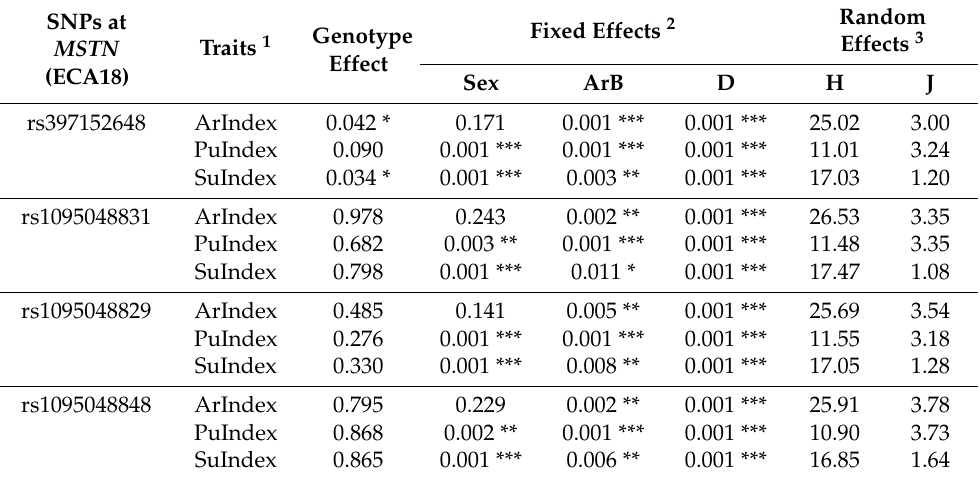
Table 3. Raw p -values and significance for sporting performance traits in the individual race, according to genotype at equine MSTN (SNP with minimum allele and genotype frequencies higher than 0.05, one SNP at a time) fixed effects, and the proportion of variance (in percentage) explained by the random effects of the individual horse and the jockey computed in model (M2); samples from 1239 races ran by 180 Anglo-Arabian horses in their debut year (three year of age).